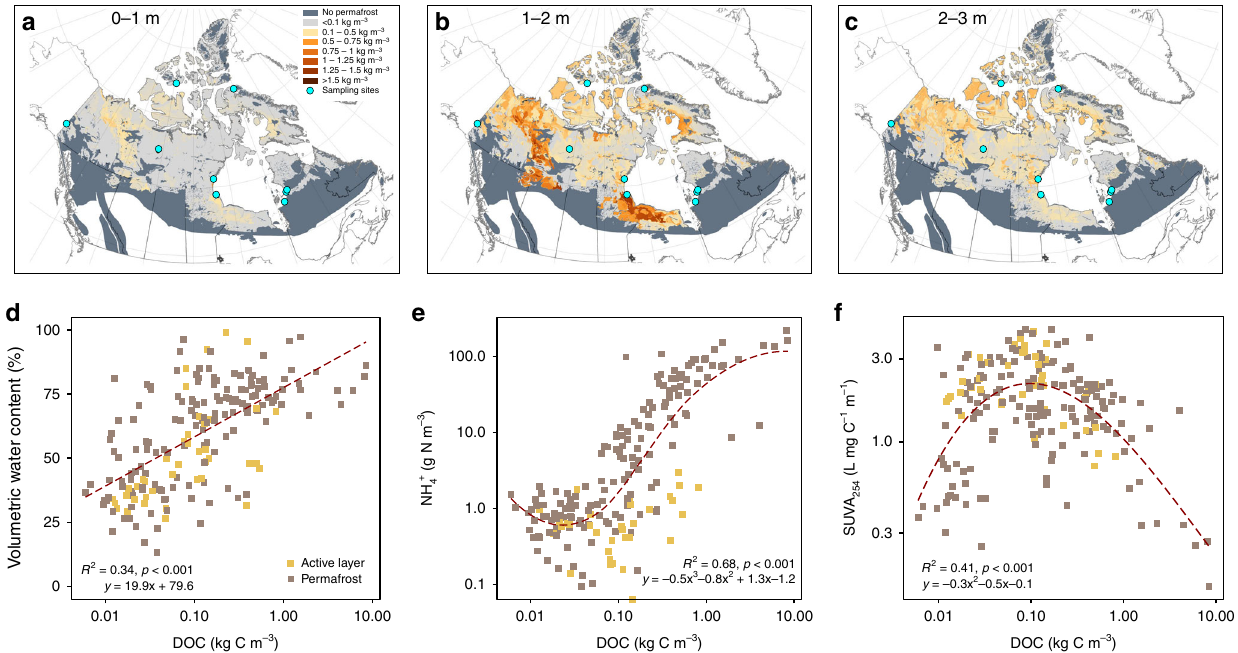
Fig. 6 Maps and controls of the DOC pool in the pan-Canadian permafrost area. a – c Maps of pool of DOC (kg C m − 3 ) that would be available upon permafrost thaw for three soil layers: 0 – 1 m, 1 – 2 m, 2 – 3 m. The DOC pool in permafrost soils was estimated by multiplying soil carbon pool of the three different gelisol types from the NCSCDv2 by the median of water extractable DOC yield of mineral and organic soils. Blue dots represent the locations of the coring sites. The dark gray area represents the non-permafrost soils within the Canadian permafrost distribution zone (isolated, sporadic, discontinuous and continuous). d Volumetric water content (%), e pool of NH 4 + (g N m − 3 ), and f SUVA 254 (L mg C − 1 m − 1 ) as a function of the pool of DOC (kg C m − 3 ) for both active layer and permafrost samples. Each point represents one sample. The regression lines (dashed lines) and equations are for active layer and permafrost samples